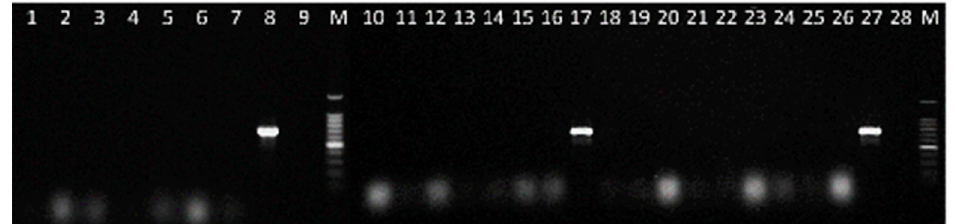
Figure 4. Specificity of PCR using the primer pair CLF/CLR for the detection of C. lupini . Lane 1 = C. tamarilloi , Lane 2 = Colletotrichum sp., Lane 3 = C. costaricense , Lane 4 = C. abscissum , Lane 5 = C. cuscutae , Lane 6 = C. paranaense , Lane 7 = C. melonis , Lane 8, 17 and 27 = C. lupini IMI 504893, Lane 9 and 28 = Negative control (without DNA), Lane 10 = C. simmondsii , Lane 11 = C. nymphaeae , Lane 12 = C. fioriniae , Lane 13 = C. acutatum , Lane 14 = C. godetiae , Lane 15 = C. salicis , Lane 16 = C. phormii , Lane 18 = C. fructicola , Lane 19 = C. tofieldiae , Lane 20 = C. orchidophilum , Lane 21 = C. higginsianum , Lane 22 = C. graminicola , Lane 23 = C. coccodes , Lane 24 = C. spinaciae , Lane 25 = C. trichellum , Lane 26 = C. truncatum , and Lane M = 100 bp DNA ladder.